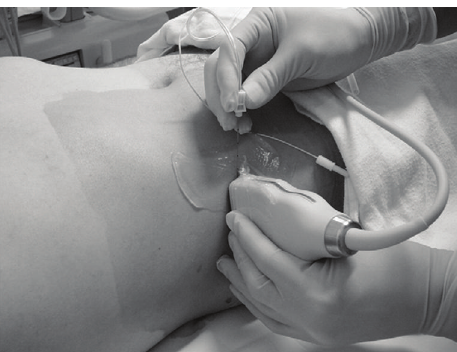
Figure 4: Ultrasound-guided TAP block showing needle alignment and ultrasound transducer placement on skin using an in-plane technique [20]. Reproduced with permission.